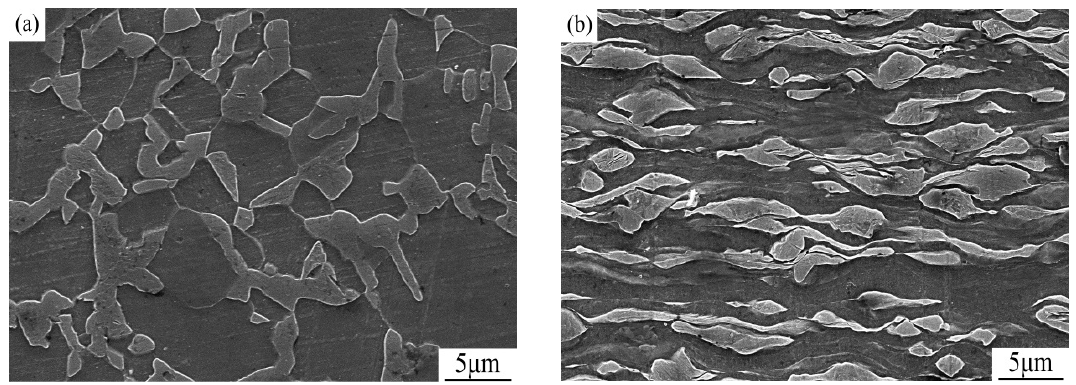
Figure 1. Microstructures of dual-phase steel ( a ) before cold rolling and ( b ) after cold rolling.